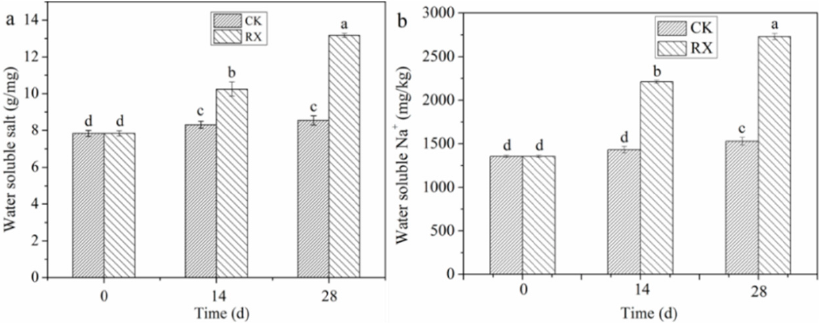
Figure 4. Change in water-soluble salt and water-soluble Na + content after the application of ZH-1. ( a ) Water soluble salt; ( b ) water soluble Na + . The different lowercase letters above the column indicate the water-soluble salt and Na + with significant differences (ANOVA, Tukey test, p < 0.05).